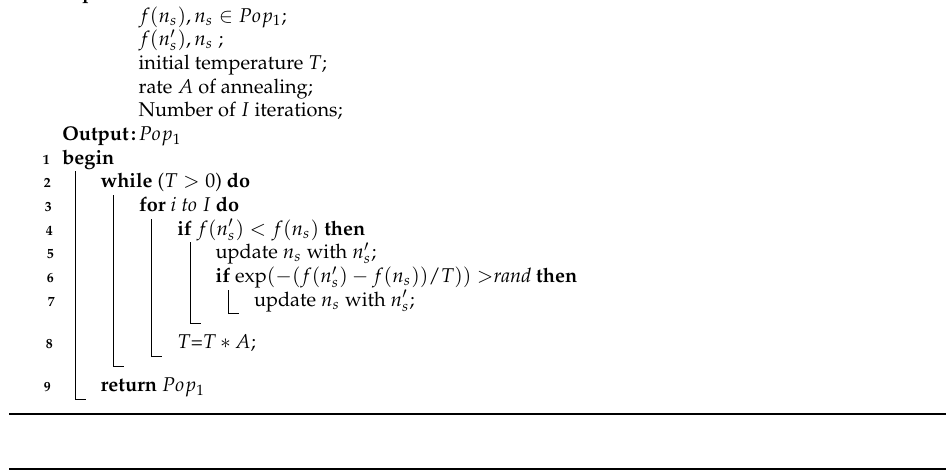
Algorithm 4: LATAS